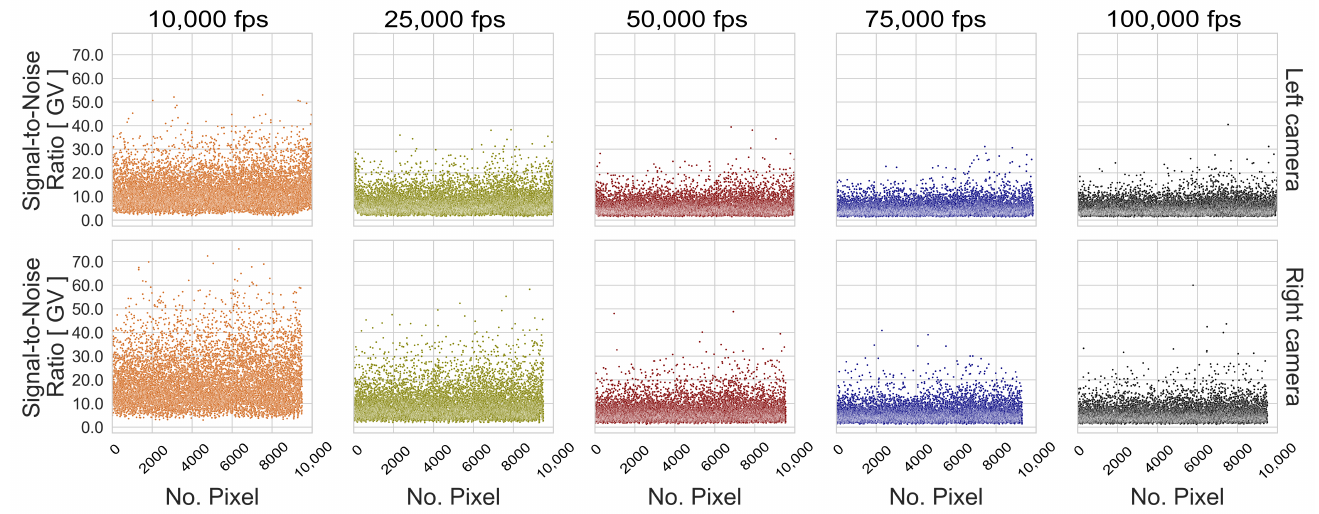
) of RP 06, considering the 5 recorded px